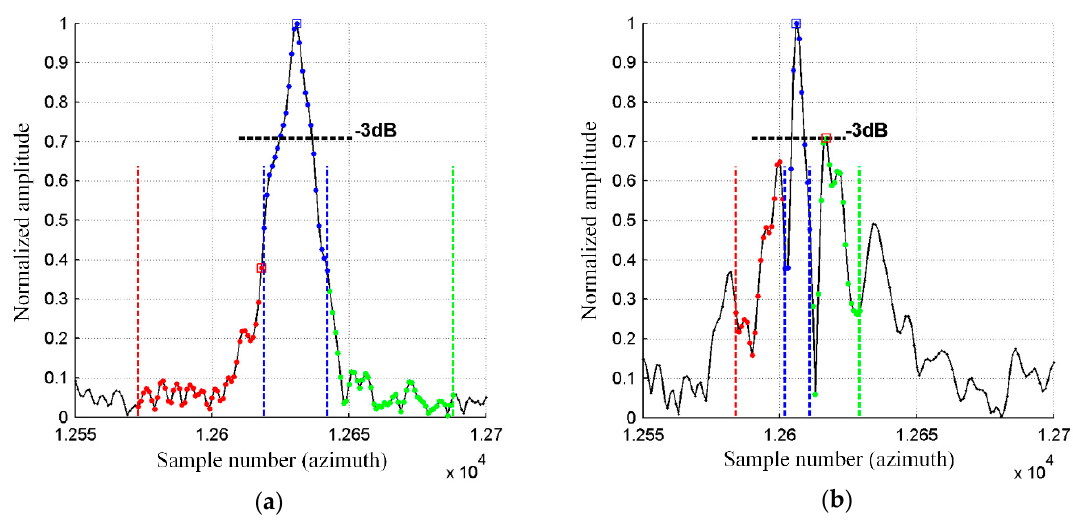
Figure 11. Image of the arrow made of corner reflectors: ( a ) with the INS-based motion compensation